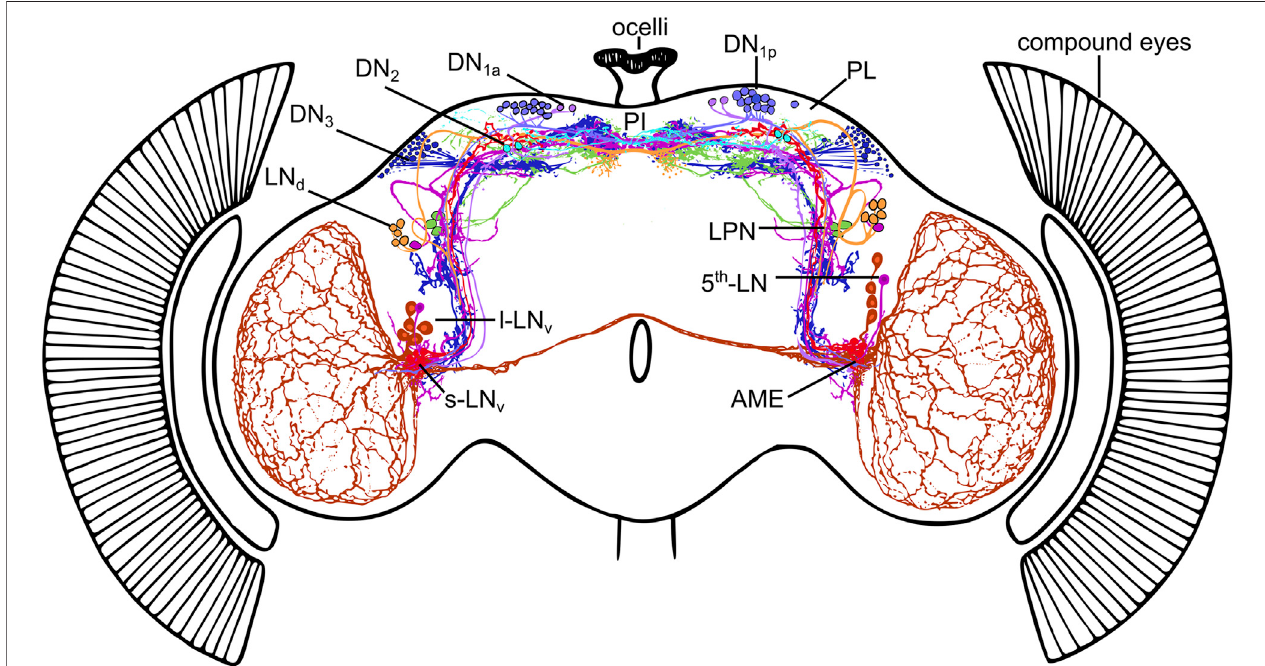
FIGURE1| Thecircadianclockneuronsinthebrainof Drosophilamelanogaster .TheclocknetworkconsistsofLateral Neurons (s-LN v s,5 th -LN,l-LN v s,LN d s , and LPNs) and Dorsal Neurons (DN 1a s, DN 1p s, DN 2 s, DN 3 s), the neurites of which are highly connected. Many of them send fi bers into the dorsal protocerebrum (including the neurosecretory centers in the pars intercerebralis (PI) and pars lateralis (PL)) as well as into the accessory medulla (AME) of both hemispheres, small neuropils at the base of the medulla. The AME can be regarded as the communication center of the clock neurons. Modi fi ed from Helfrich-Förster et al., 2007a with data from Schubert et al., 2018 and Reinhard et al., 2022 and this